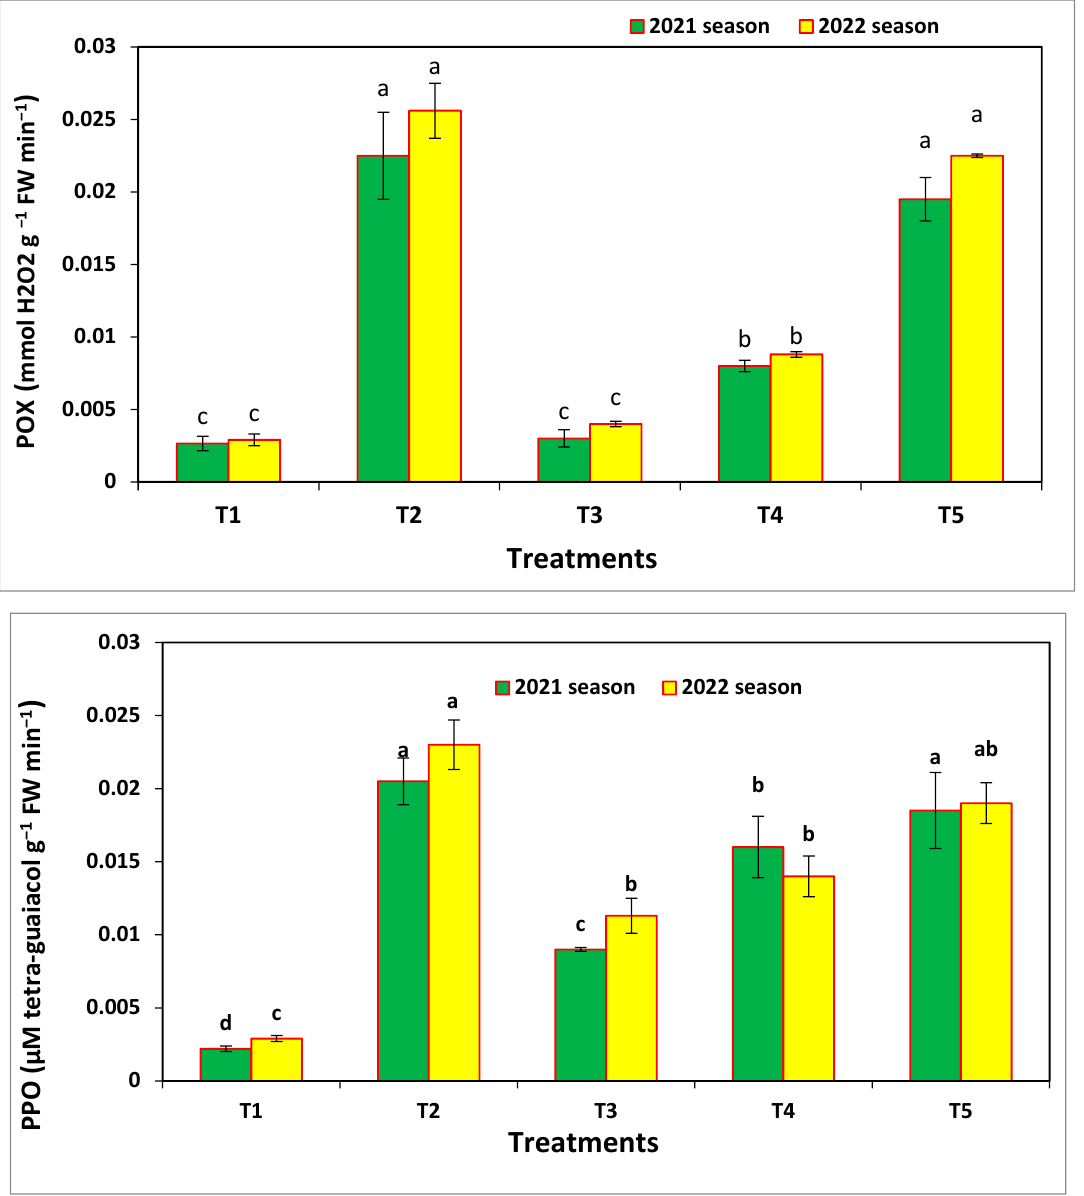
Figure 8. Effects of the different treatments on catalase, peroxidases, and polyphenol oxidase activity in the bean plants measured 70 days after sowing in the field experiments, and where T1 = negative control, T2 = 100 ppm nano-Se, T3 = 200 ppm nano-Si, T4 = 1/2 nano-Se + Si, and T5 = fungicide (Score 250 EC at 1 mL/2 L). Same letter above the error bar indicates no significant differences.